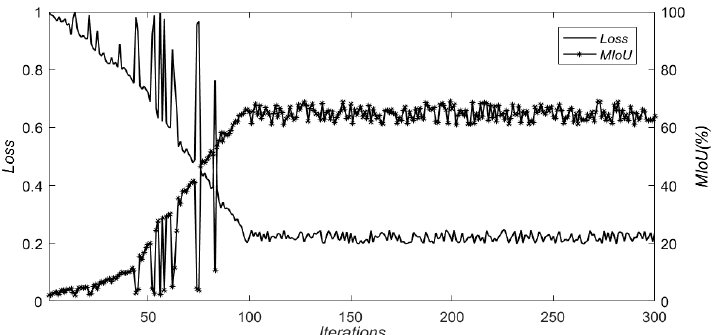
Figure 5. The iteration loss and mean intersection over union ( MIoU ) of the fully convolution neural network.